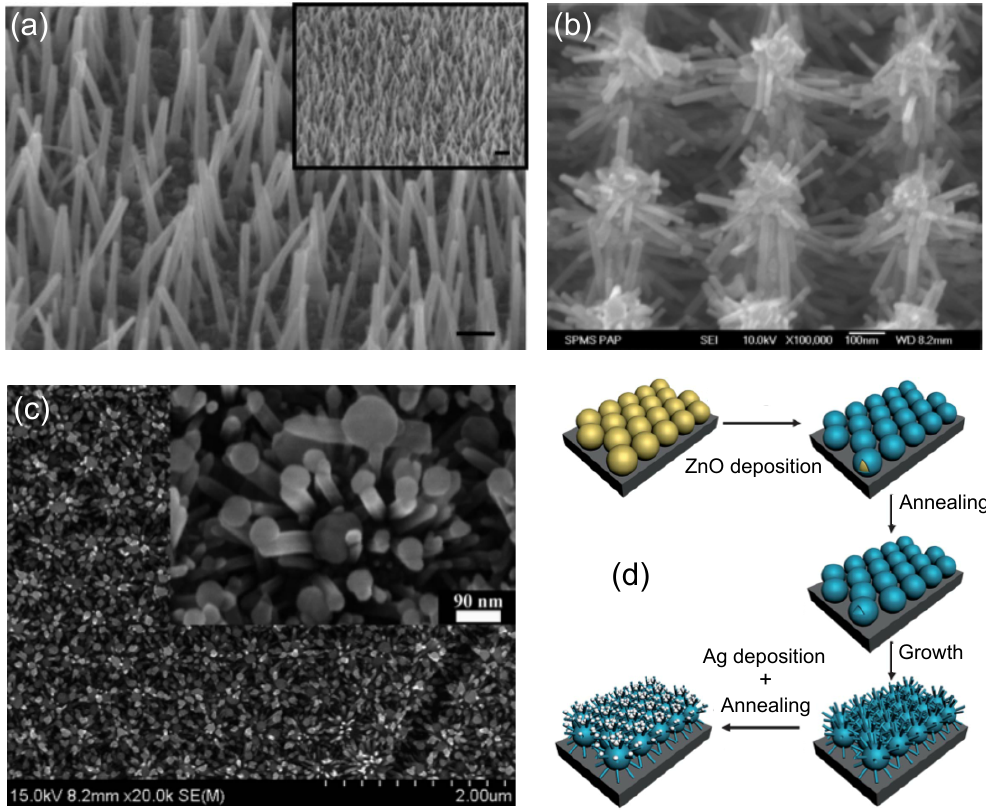
Figure 3. Three examples of metal-coated ZnO nanostructures: ( a ) SEM images of Au/ZnO nanorods and the insert is a picture at a weaker magnification (scale bars = 100 nm; reprinted with permission from [42], copyright 2011 American Chemical Society); ( b ) SEM image of AgNP-decorated Si/ZnO nanotrees (scale bar = 100 nm; reprinted with permission from [81], copyright 2010 American Chemical Society); ( c ) SEM images of an urchin-like AgNPs/ZnO hollow nanosphere (HNS) array and the insert corresponds to a picture recorded with a higher magnification; ( d ) principle scheme of the low-cost fabrication process of urchin-like AgNPs/ZnO HNS array; ( c , d ) are reproduced from [88] with permission from the Royal Society of